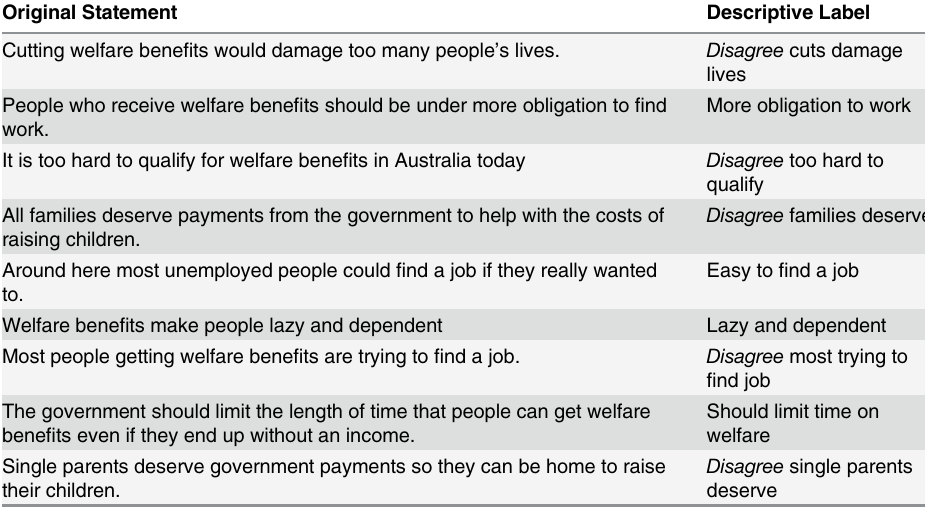
Table 1. Attitudinal items collected in AuSSA